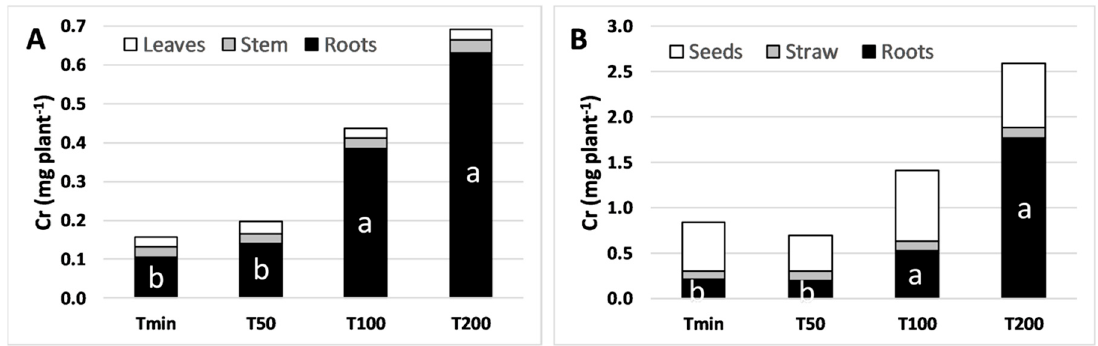
Figure 4. Plant chromium accumulation in each biomass fraction of fiber ( A ) and seed ( B ) varieties at harvest time. Different letters indicate significant differences among sludge treatments for the same biomass fraction at p < 0.01 (Tukey’s HSD test).